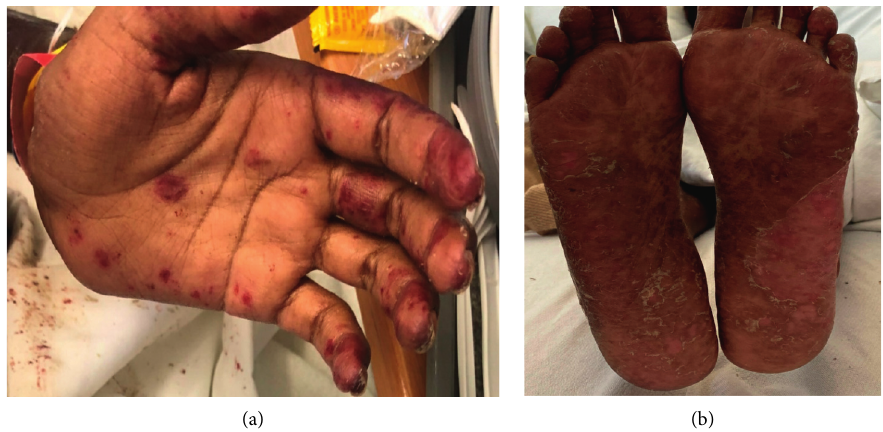
Figure 1: Chilblain lupus erythematosus (LE), deep red to violaceous plaques on palms and soles. Some appear annular targetoid pain and pruritis.